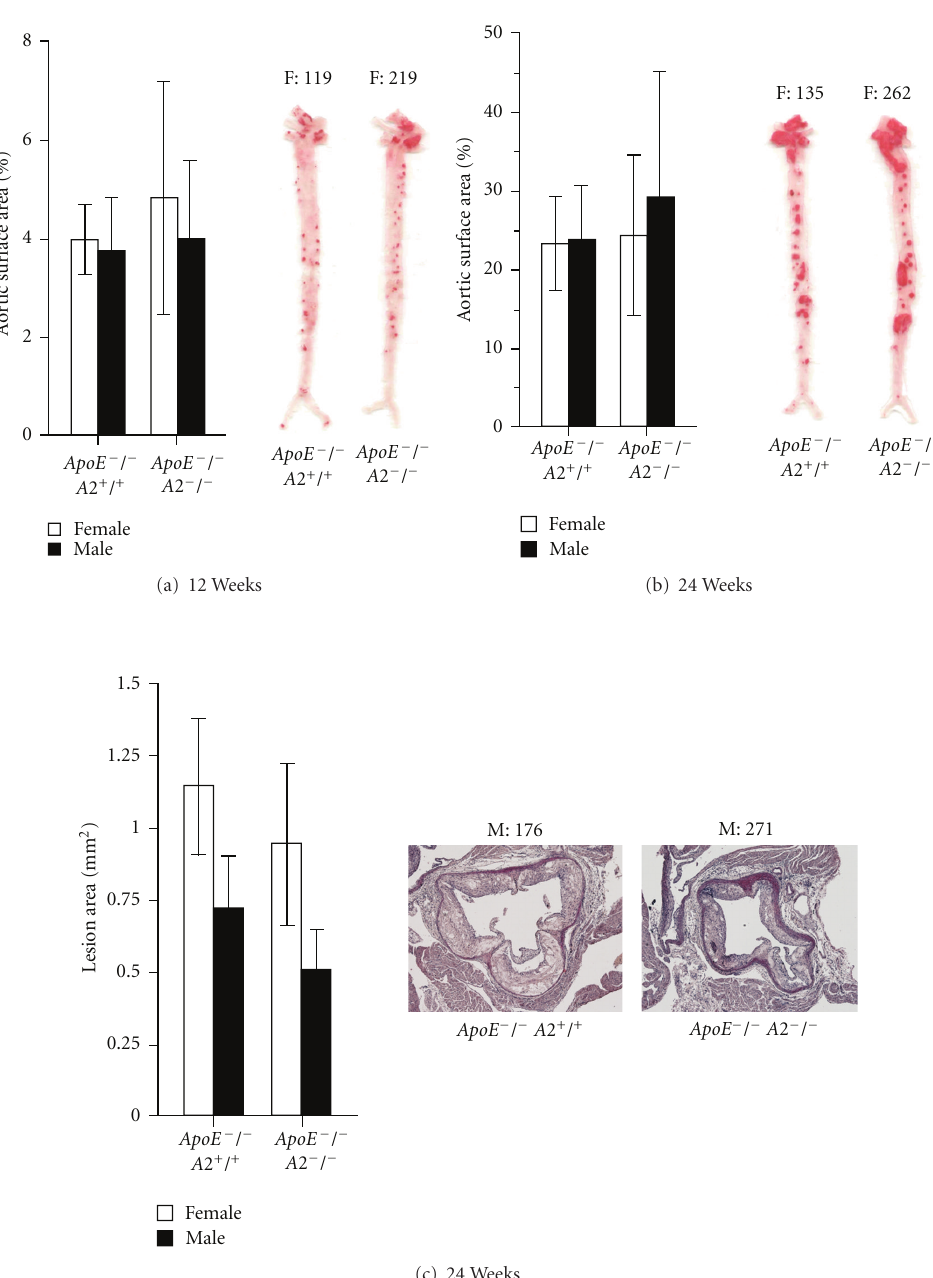
Figure 2: Diet-induced atherogenesis in AnxA 2 + / + and AnxA 2 − / − mice. AnxA 2 − / − mice on the C57Bl/6 background were backcrossed to ApoE − / − mice (Jackson Laboratories) to generate AnxA 2 − / − ApoE − / − double knockout mice. At 3 weeks of age, both AnxA 2 + / + ApoE − / − and AnxA 2 − / − ApoE − / − mice male and female mice were placed on a western diet, composed of 1% (wt/wt) adjusted calories from fat and 0.15% (wt/wt) cholesterol (TD88137, Harland Tekland Laboratory) ad libitum , for 12 ( n = 14–20 mice/group) or 24 weeks ( n = 17–23 mice/group). At 12 or 24 weeks (a and b, resp.), the animals were perfused with PBS for 20 minutes, whereupon the entire aorta from the heart to 5–10 mm below the bifurcation of the iliac arteries was removed and fixed in 4% paraformaldehyde. The aorta was evaluated for lesion development by en face Oil red O staining, and morphometry of digital images of the stained aortas was performed using Adobe Photoshop 7.0 software [24]. For aortic root analyses, hearts removed at 24 weeks (c) were fixed in 3% PFA and para ffi n embedded. Serial sections, 10 microns in thickness, obtained from the region of the proximal aorta to the level of the aortic leaflet, were stained with hematoxylin and eosin. Digital microscopic images were analyzed using image analysis software (NIH Image 1.63). Lesion size for each mouse was calculated as the average lesion size in 10–15 sections over a distance of 200 to 300 microns in the aortic root. Representative lesions are